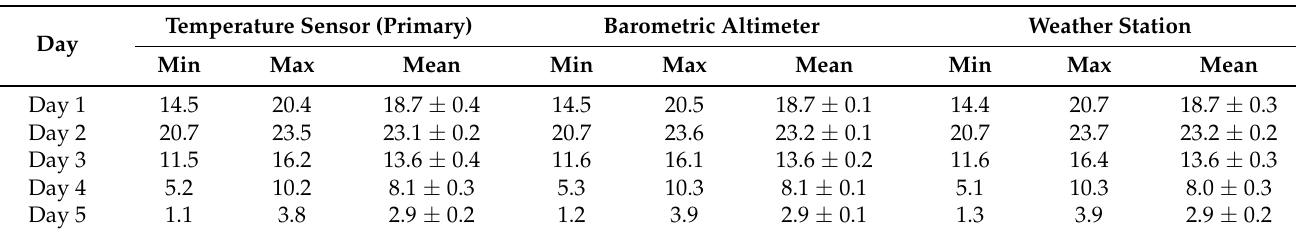
Table 3. Ambient temperature (in ◦